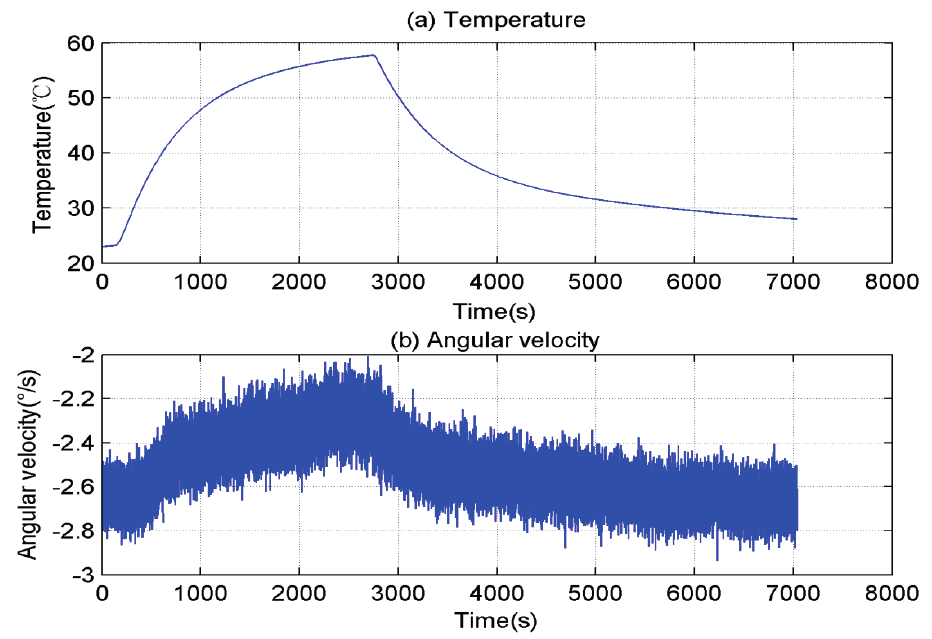
Figure 1. Original data of motionless gyroscope. ( a ) Temperature variation; ( b ) Angular velocity. The blue line in Figure 2 is the uncompensated angular velocity of the motionless gyroscope, the red line is the estimation of the gyroscope bias, and the green line is the ideal bias. We can see that the bias estimation follows the ideal bias very well.